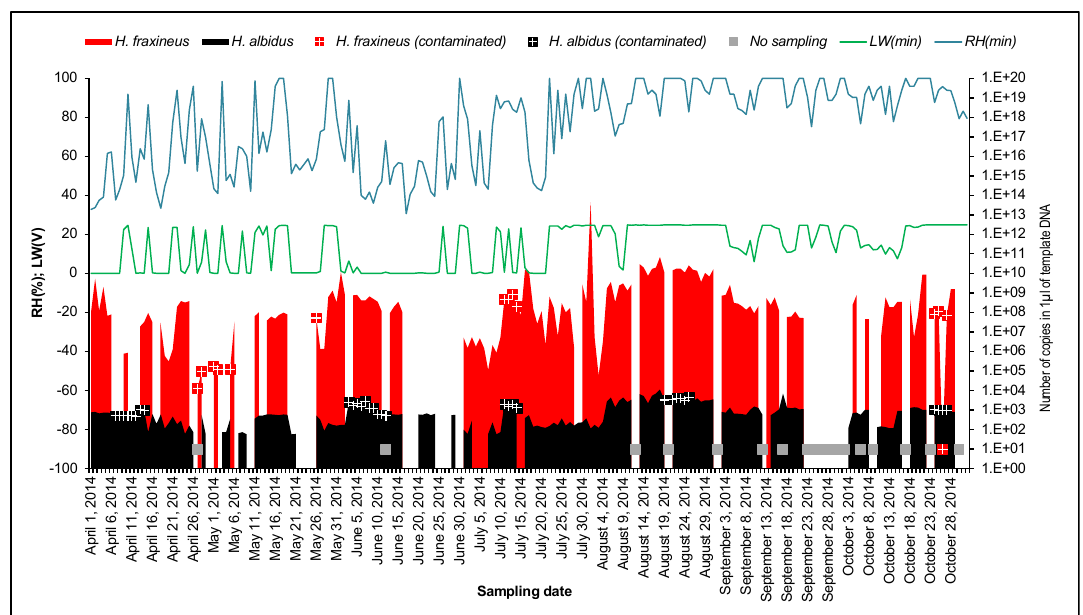
Figure 3. Seasonal spore dispersal pattern of H. fraxineus and H. albidus (numbers of copies of the target sequence in 1 µL of template DNA in particular days of sampling by SAVST in logarithmic scale), accompanied by curve of minimal leaf wetness (LW—dimensionless value) and minimal air relative humidity (RH—%). Black squares with grey “X” indicate days without sampling, black or grey squares with white “+” are qPCR results of reaction with contamination in negative control of DNA extraction.